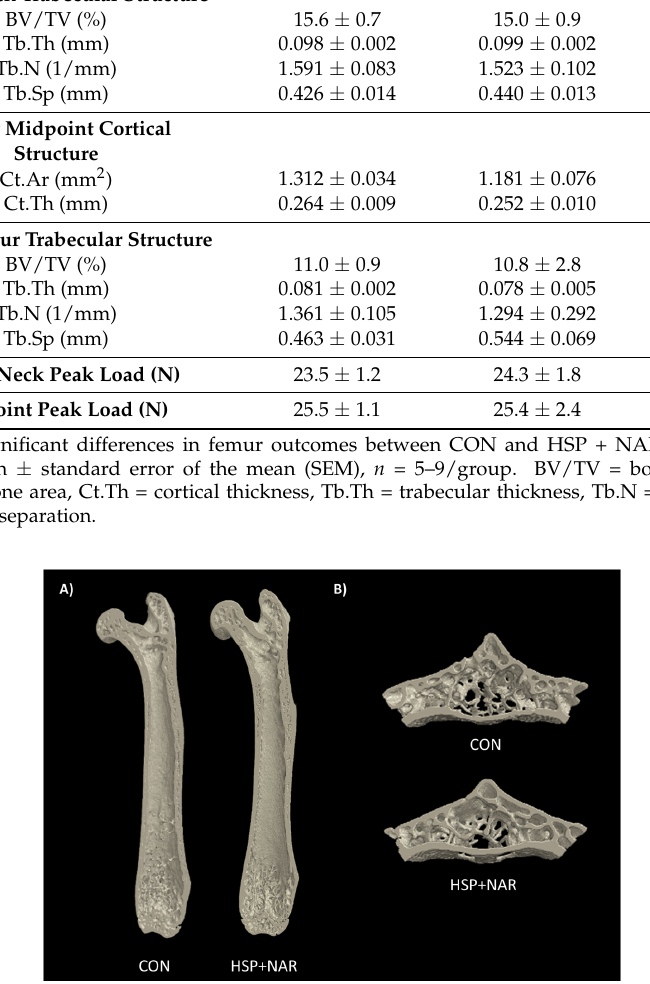
Figure 3. Representative images of the right femur ( A ) and the second lumbar vertebra (LV2) ( B ) of 6 ‐ month ‐ old female mice whose mothers were exposed to control (CON) or 0.5% hesperidin (HSP) and 0.25% naringin (NAR) diets through pregnancy and lactation. Coronal sections consisting of the ventral half of the femur are depicted in ( A ); Transverse sections consisting of 1.011 mm of the vertebral body midsection are depicted in ( B ). Table 3. Ex vivo bone mineral density (BMD), structure and peak load of the lumbar vertebra (LV) in 6 ‐ month ‐ old female CD ‐ 1 mice whose mothers were exposed to control (CON) or 0.5% hesperidin (HSP) + 0.25% naringin (NAR) diets through pregnancy and lactation.